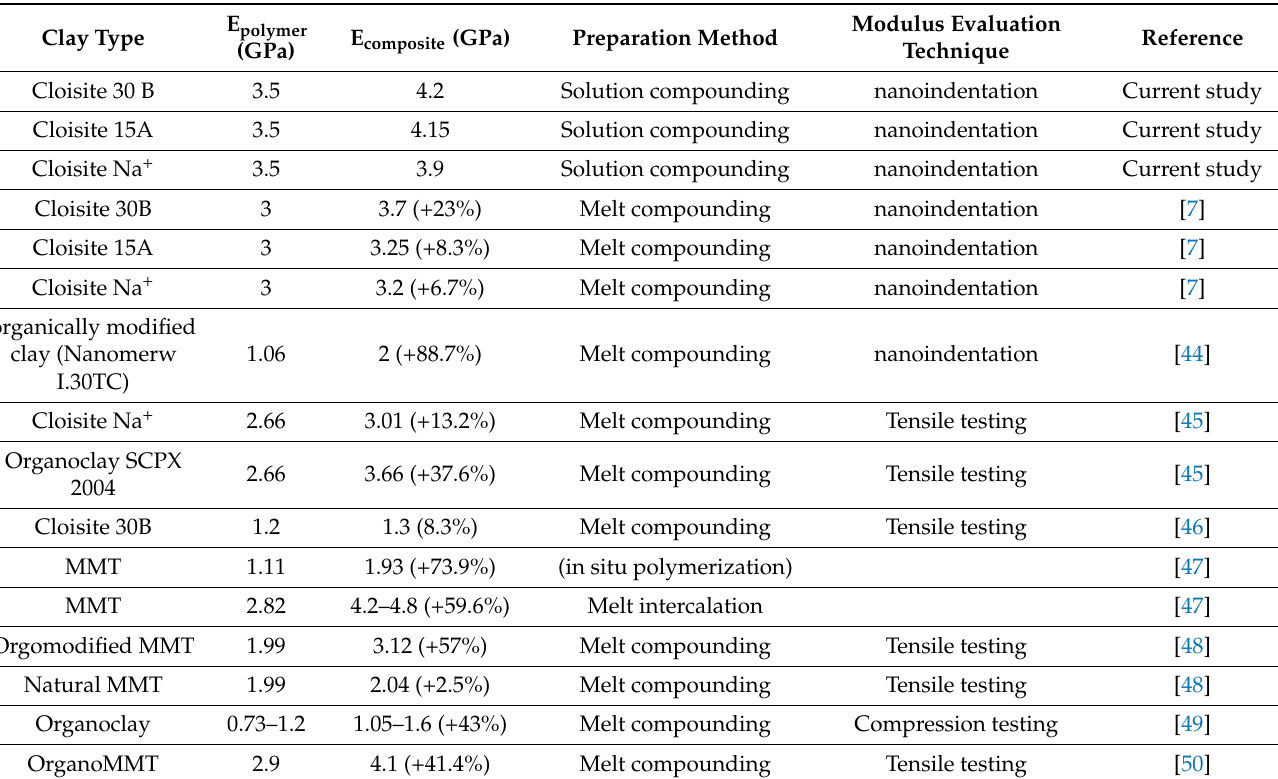
Table 4. Comparing results of the current study to some reported Moduli of nylon6-montmorillonite